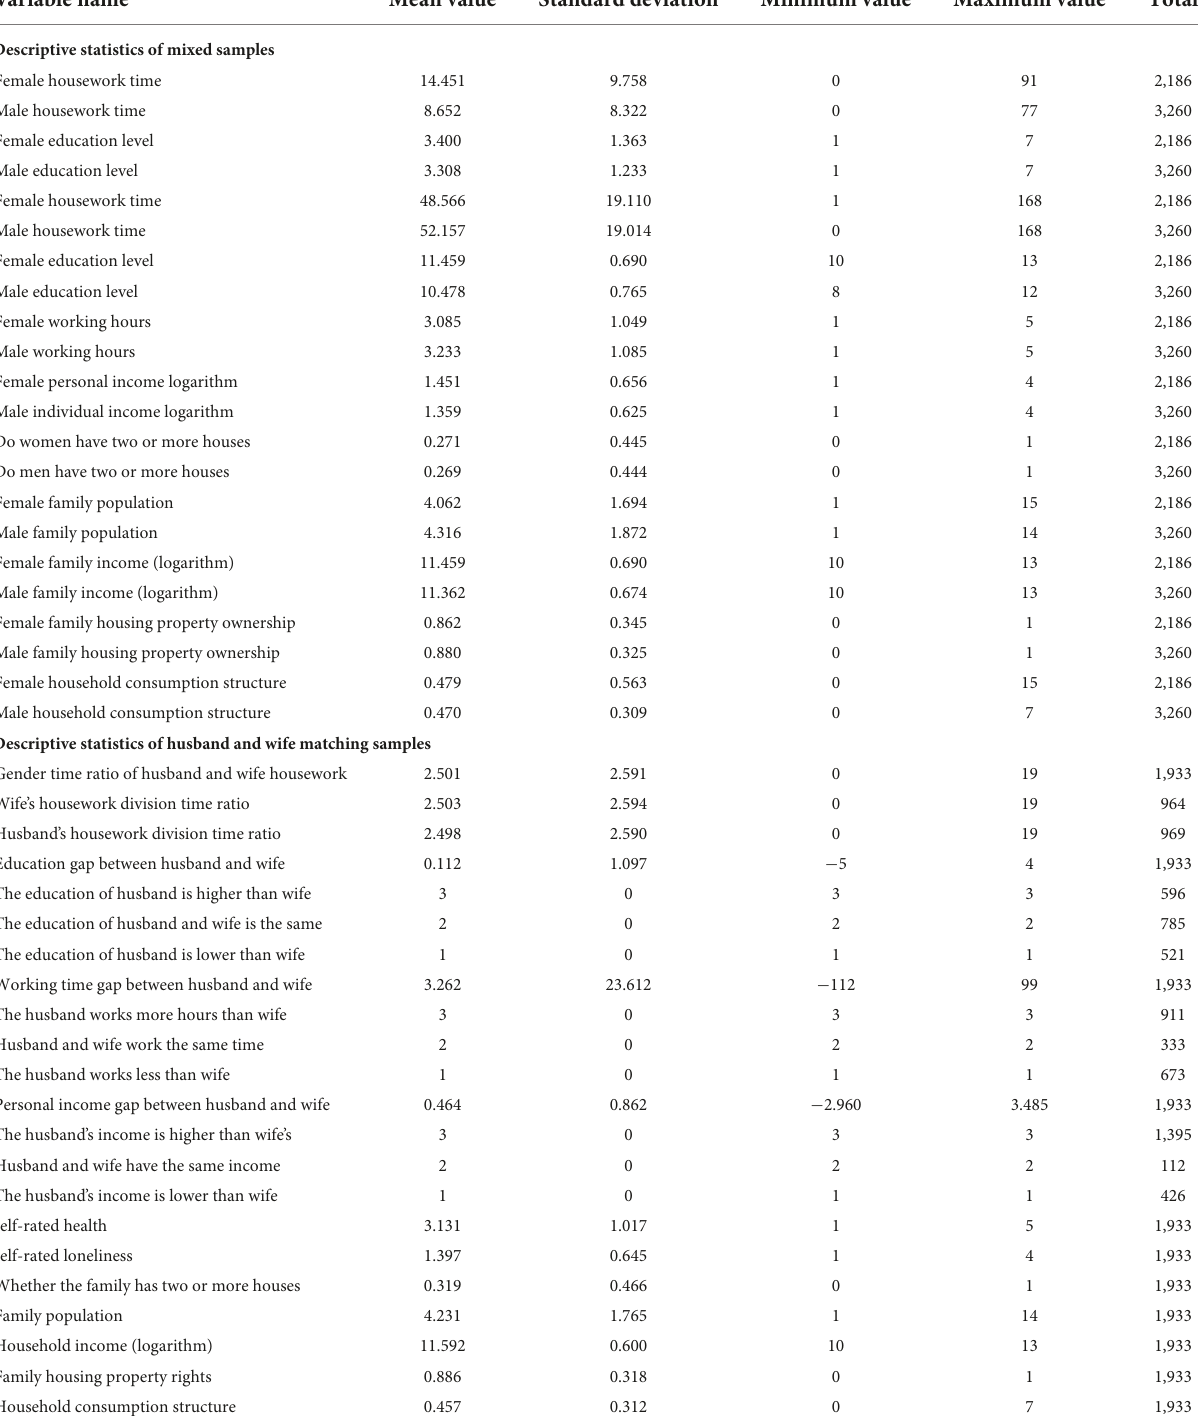
TABLE 1 Descriptive statistics of